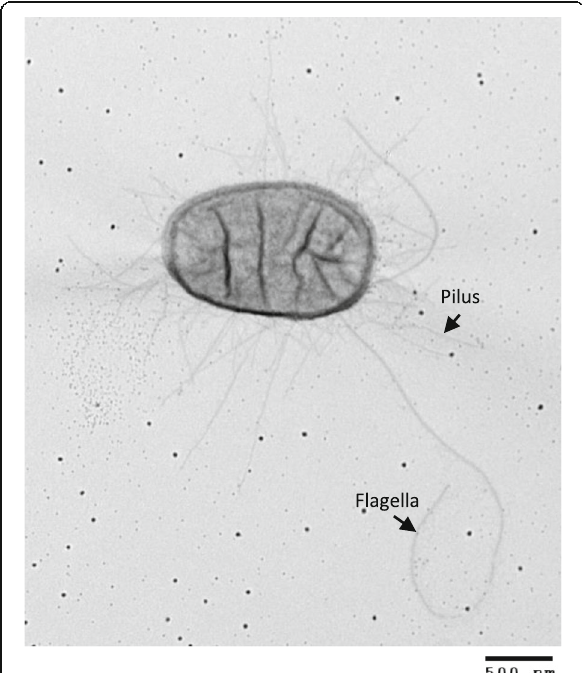
Fig. 1 Transmission electron micrograph of E. coli BG1. The strain BG1 is a rod-shaped bacteria with a length of 1.5 – 2 μ m and a diameter of 1 μ m. It moves via peritrichous flagella. The magnification rate is 20,000×. The scale bar indicates 500